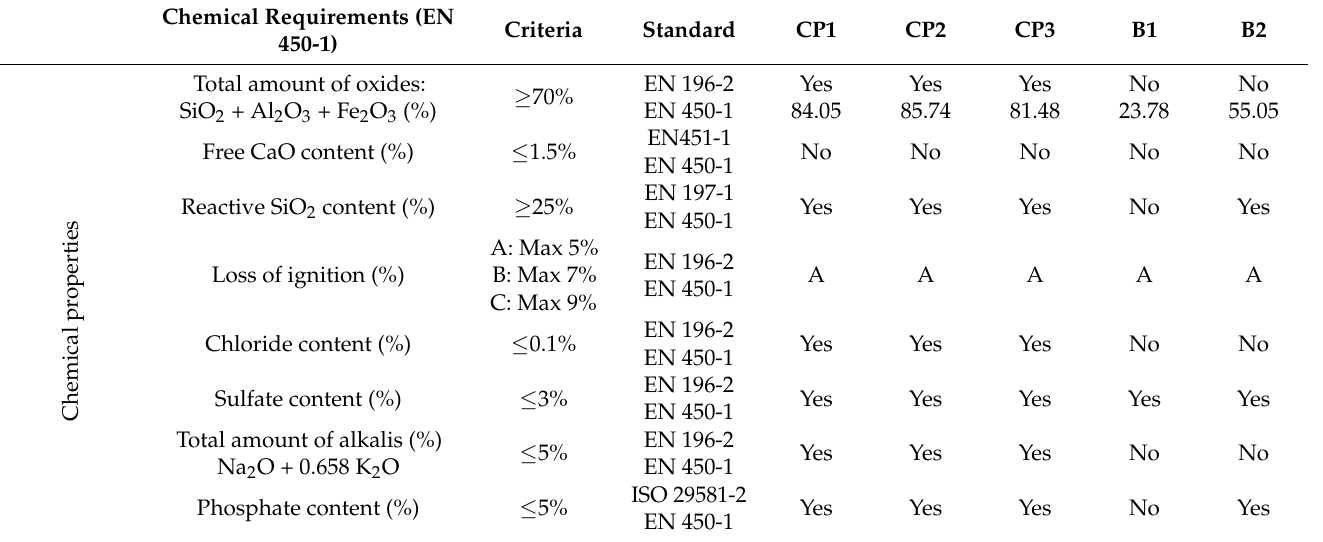
Table 4. Chemical composition—criteria